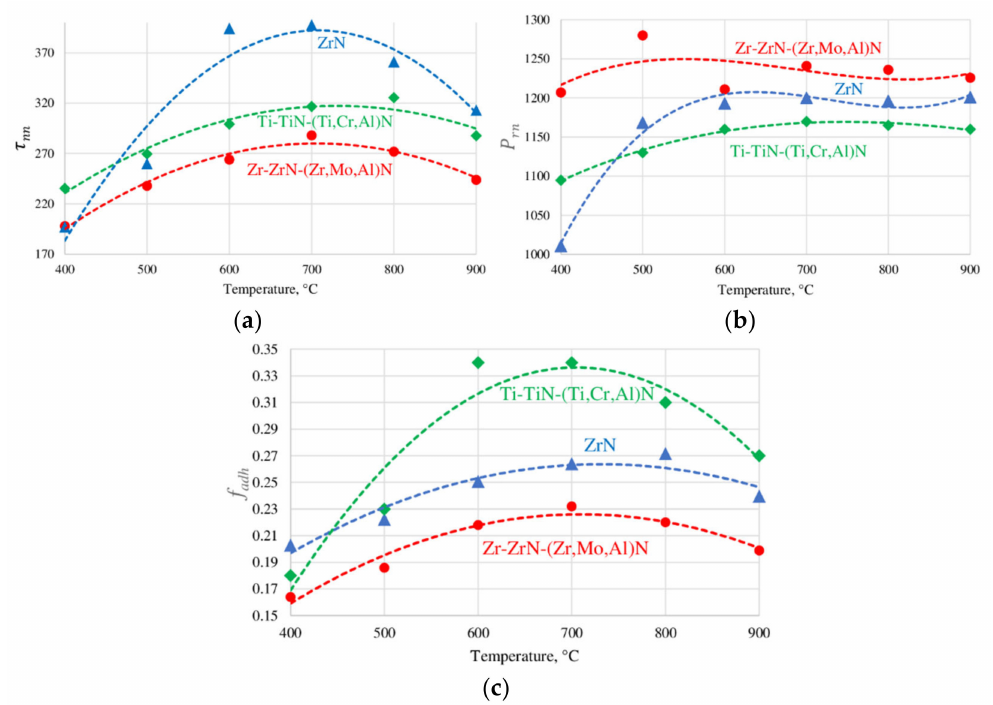
Figure 3. Investigation of the tribological properties of the coatings. ( a ) Shear strength of adhesive bonds τ nn , ( b ) value of normal stresses P rn , and ( c ) adhesive component of the COF f adh .